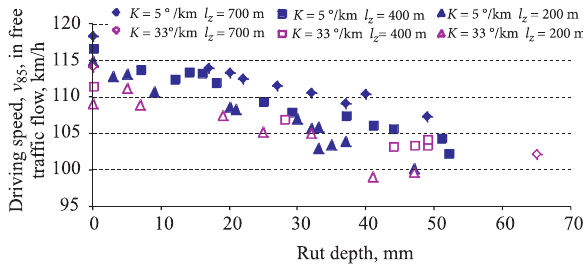
Fig. 1. Estimated speeds, v 85 , for the research sections grouped in respect of the available sight distance, road bendiness and the rut depth ( k